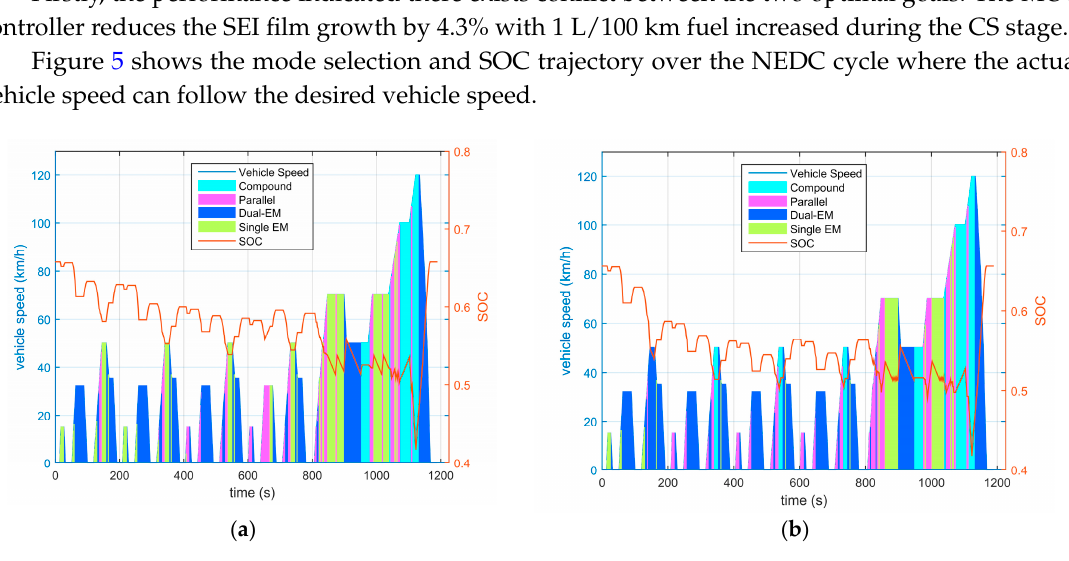
Figure 5. ( a ) SOC trajectory and mode selection with α = 0; and ( b ) SOC trajectory and mode selection with α = 0.3.